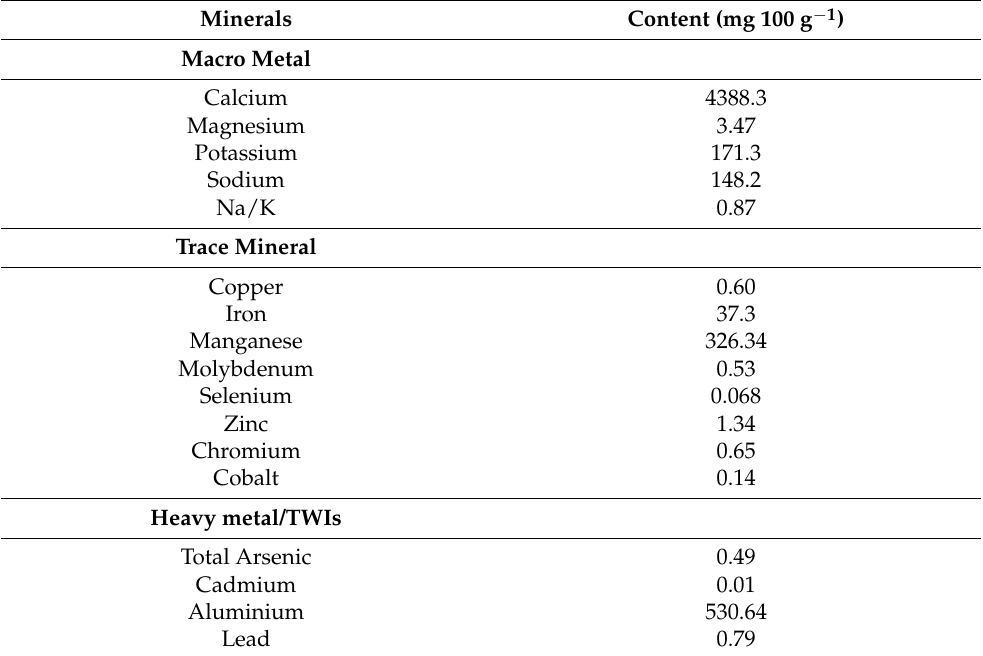
Table 4. Mineral composition in P. tetrastromatica sample ( n =